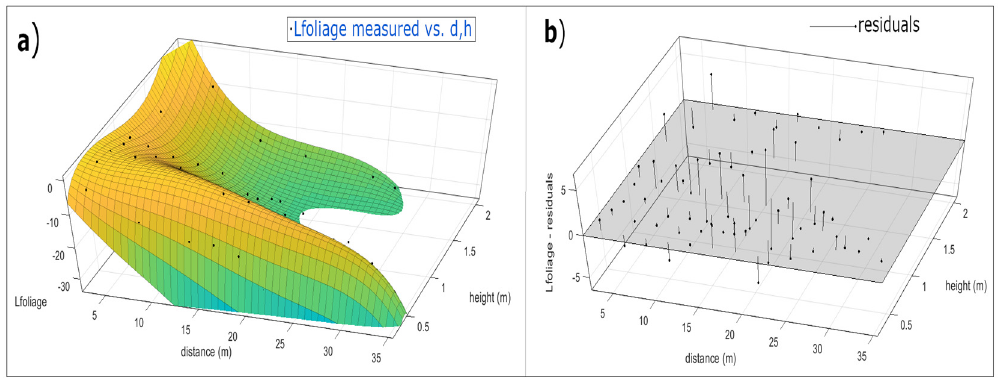
Figure 10. ( a ) Measured values represented by black dots together with the optimized L foliage ( d , h ) model for 20 parameters. ( b ) Residual values of L foliage ( d , h ) determined as di ff erence between measured data and predicted data. Table 2. Parameter values optimized using the cost function of the Equation (6). Some parameters as it can be seen have values close to zero.